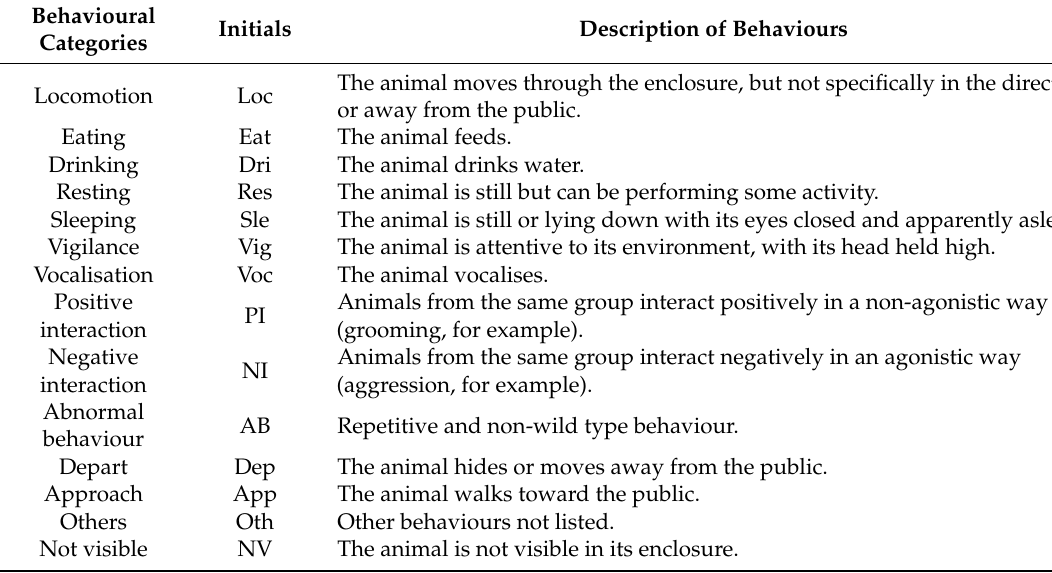
Table 2. List of behaviours observed and recorded during a study into the visitor effect on mammals at the Belo Horizonte Zoo, Minas Gerais,